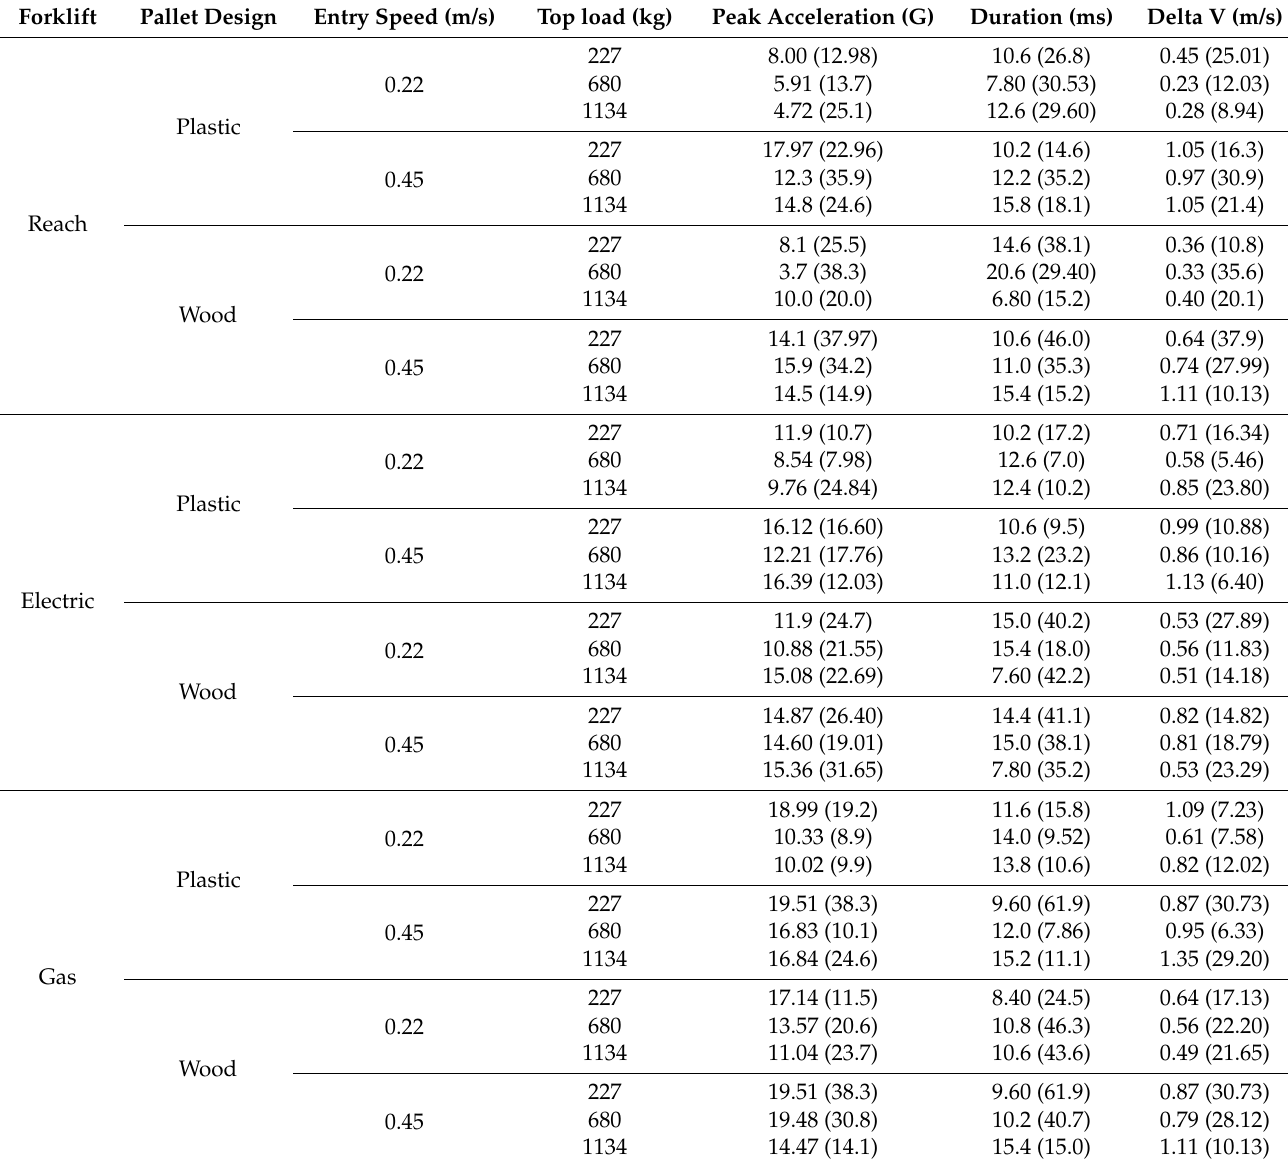
Table 5. Pallet acceleration, duration, and delta velocity response at pallets by factor configuration